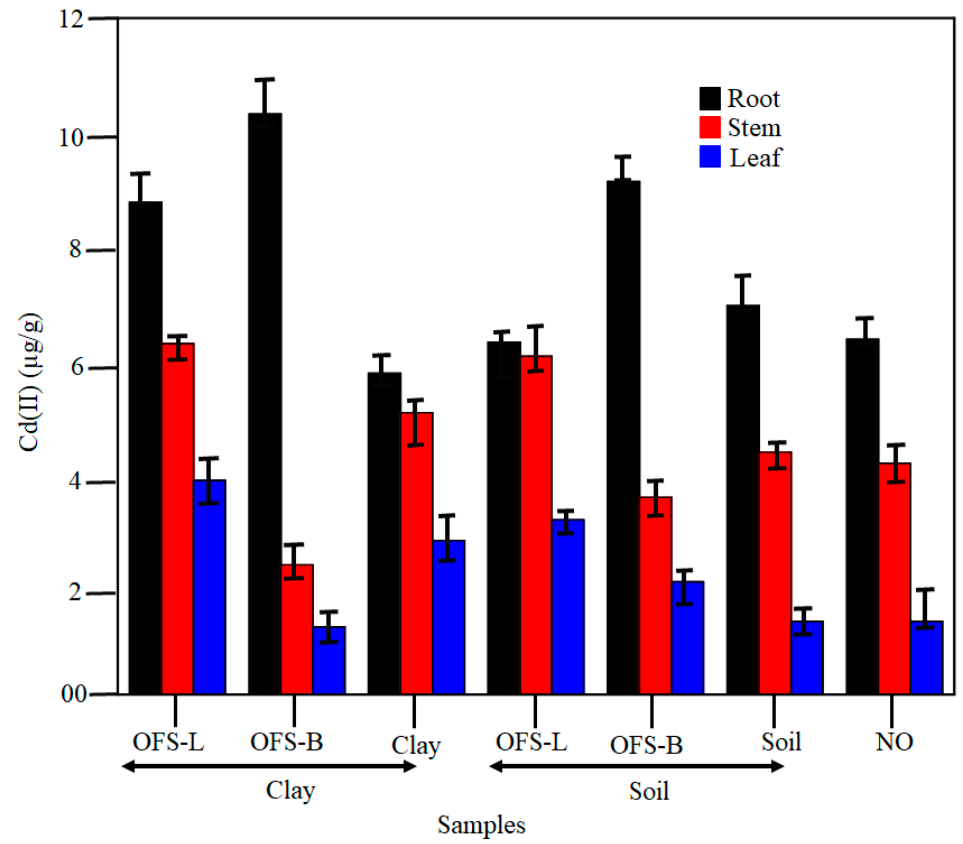
Figure 6. Concentration of Cd (II) in different part of the Cyperus alternifolius plant.